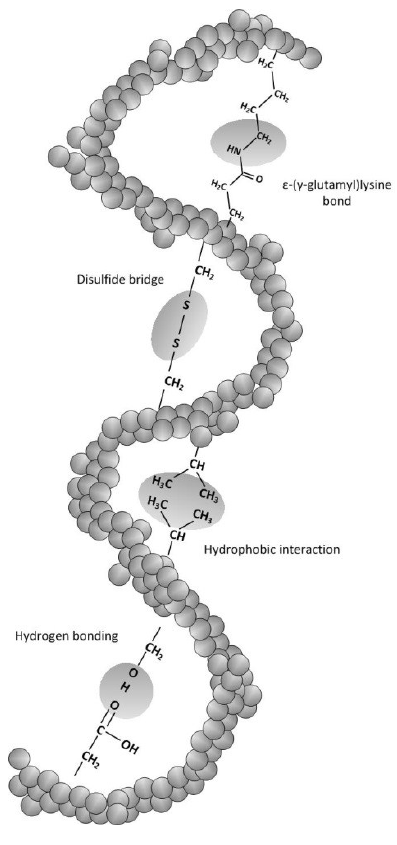
Figure 2. Schematic figure of possible inter-actions in cross-linked protein films. Adopted and extended from